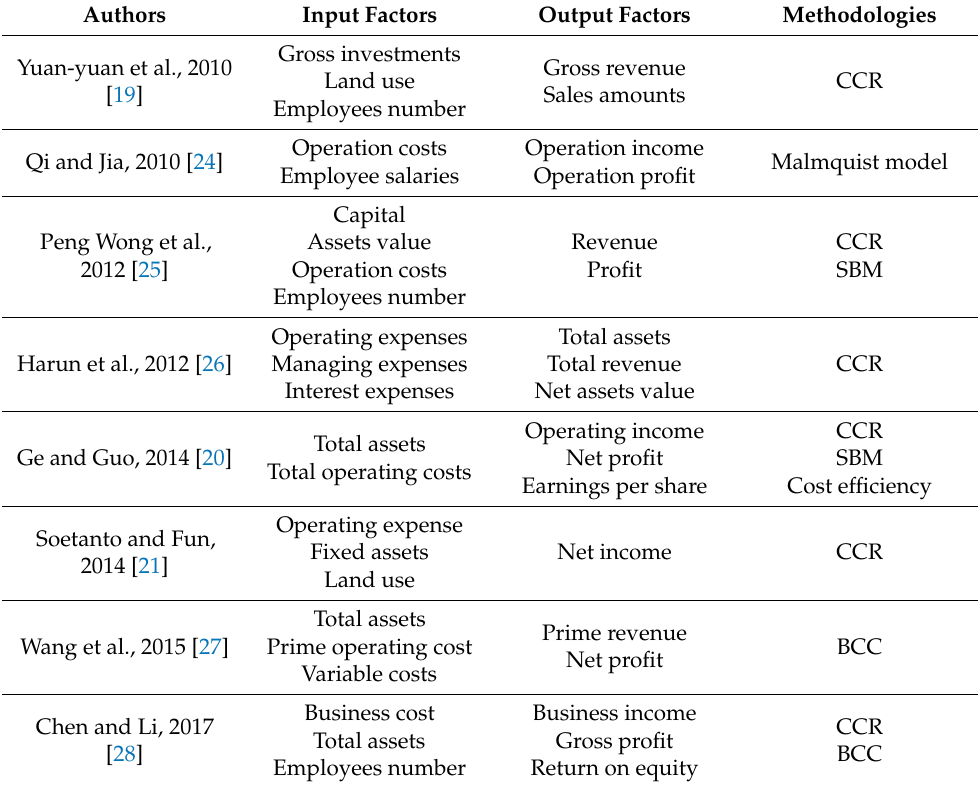
Table 2. The summary of inputs and outputs used in previous